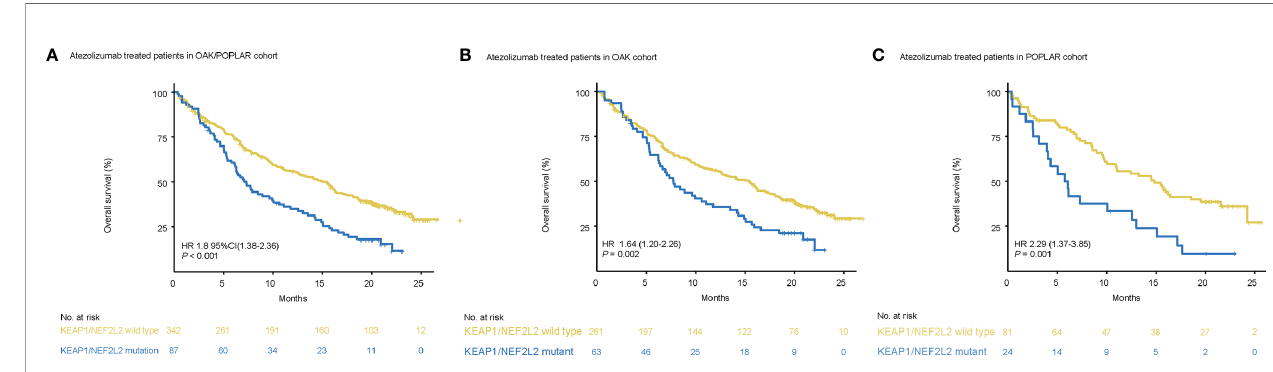
FIGURE 3 | Survival analyses in the OAK/POPLAR-atezolizumab cohorts. (A) Kaplan – Meier curves of overall survival (OS) in the atezolizumab treated patients with or without KEAP1/NFE2L2 mutations in the OAK/POPLAR cohorts. (B) Kaplan – Meier curves of OS in the atezolizumab treated patients with or without KEAP1/